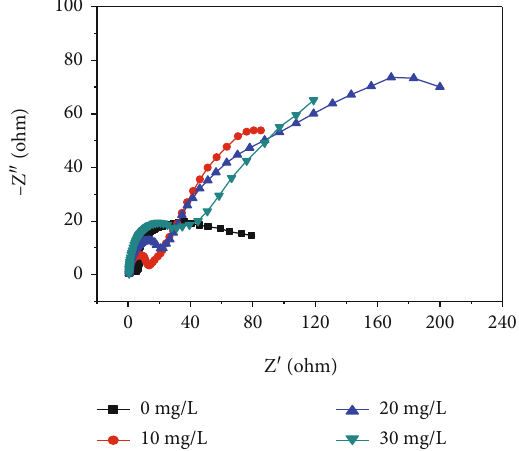
Figure 13: Nyquist diagram of carbon steel electrode in 3.5% NaCl solution with di ff erent concentrations of thiourea-modi fi ed polyepoxysuccinic acid